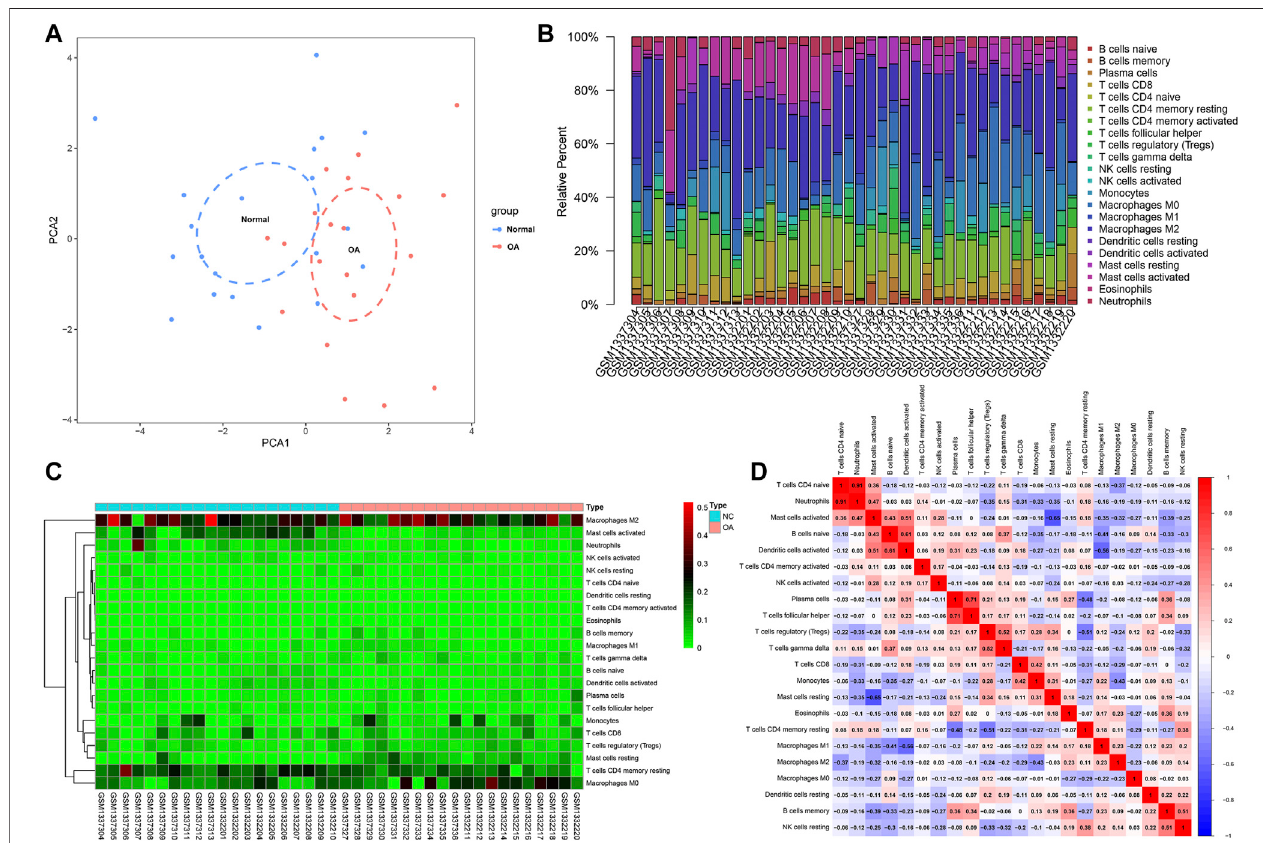
FIGURE3| Landscapeinimmunein fi ltrationbetweenOAandhealthysynovialtissuespecimensfromtheGSE55235andGSE55457datasets. (A) PCAofsynovial tissues based on immune cell in fi ltration levels. The fi rst two principal components which decipher the most of the data variation. (B) The relative percent of 22 kinds of immune cells in each specimen. (C) Heatmap of the in fi ltration levels of immune cells in OA (red) and normal (blue) synovial tissues. (D) Positive (red) and negative correlations between different immune cells in synovial specimens. Correlation coef fi cient is marked in each